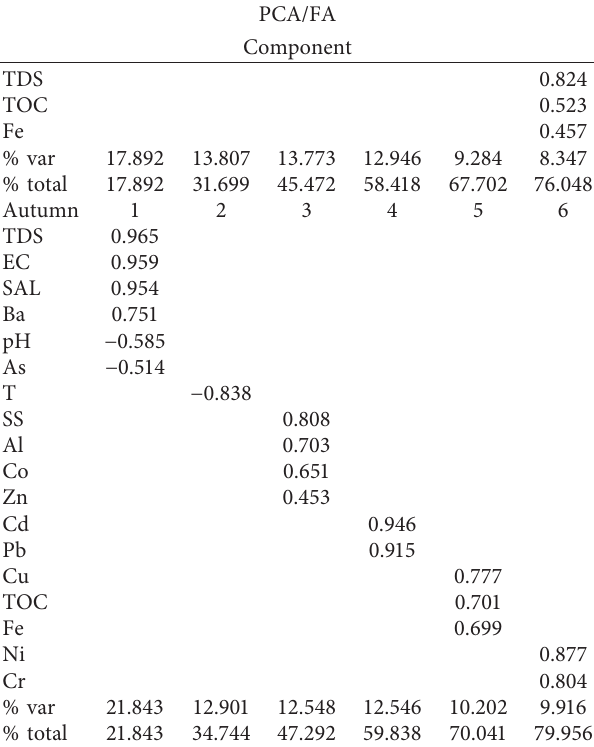
Table 2: PCA/FA varimax rotated results for winter, spring, summer, and